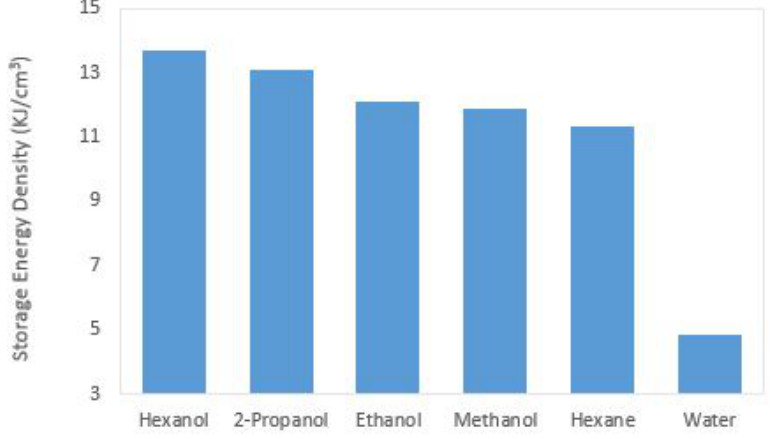
Figure 4. The energy density of the stoichiometric ratio of hydrogen peroxide and solvent. Higher energy densities allow for smaller total storage volume leading to decreased system